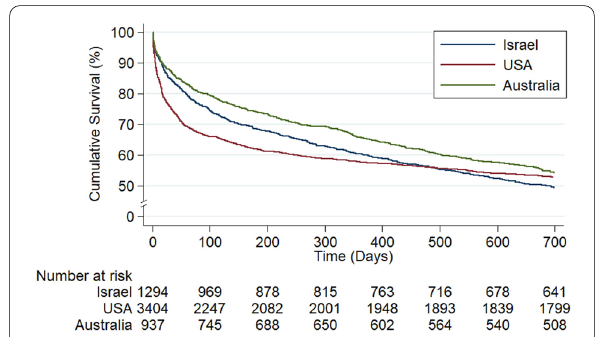
Fig. 1 Kaplan–Meier curve comparing all-cause mortality of hospital survivors among Israeli and Australian patients in the 5th quintile (see Additional file 1: Table S5) and American patients from the MIMIC